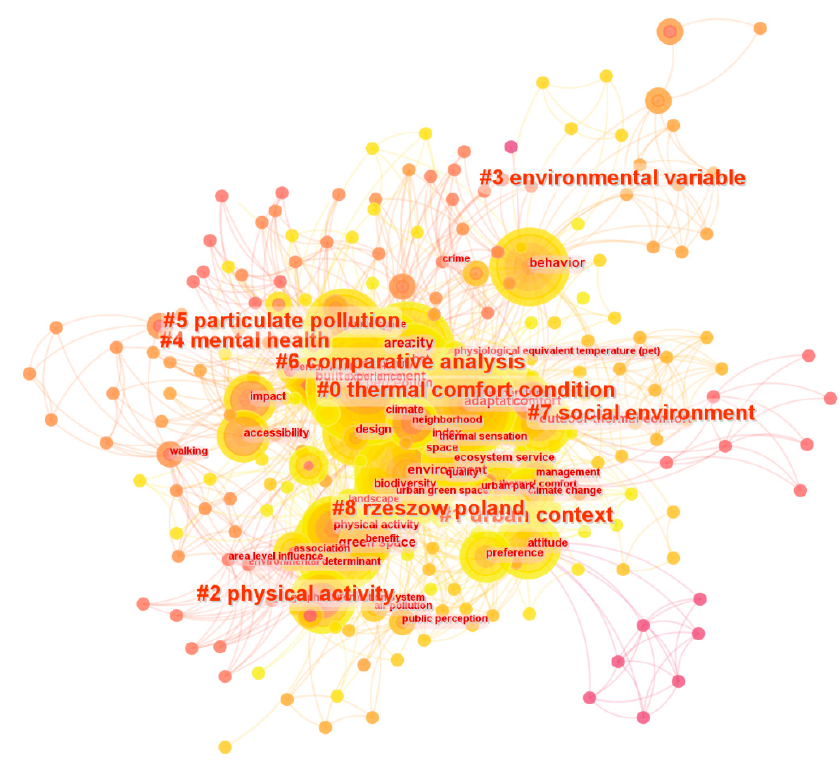
Figure 3. Co-occurrence keyword networks and clusters from 2000 to 2021.